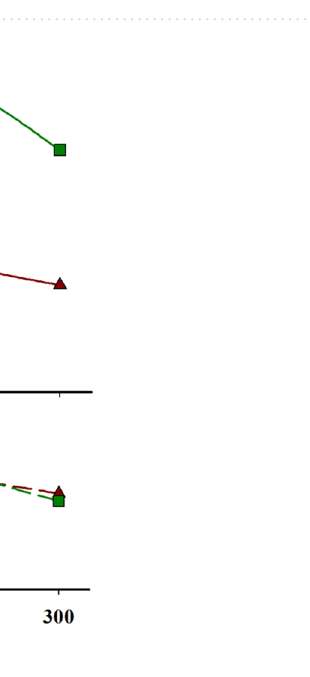
Figure 4. Schematic view of the reactions based on erythritol mediated by Ffase. The structure of the two fructosyl-erythritol enantiomers previously detected in the reaction 1 are generated due to a difference in the position of fructosylation of erythritol: 1-O-β-D-fructosyl-D-erythritol (when the linkage occurred next to the chiral center R) and 4-O-β-D-fructosyl-D-erythritol (if it occurred next to the S one). Therefore, two potential structures for fructosyl-fructosyl-erythritol detected in reactions mediated by the Ffase-N254T are also possible.